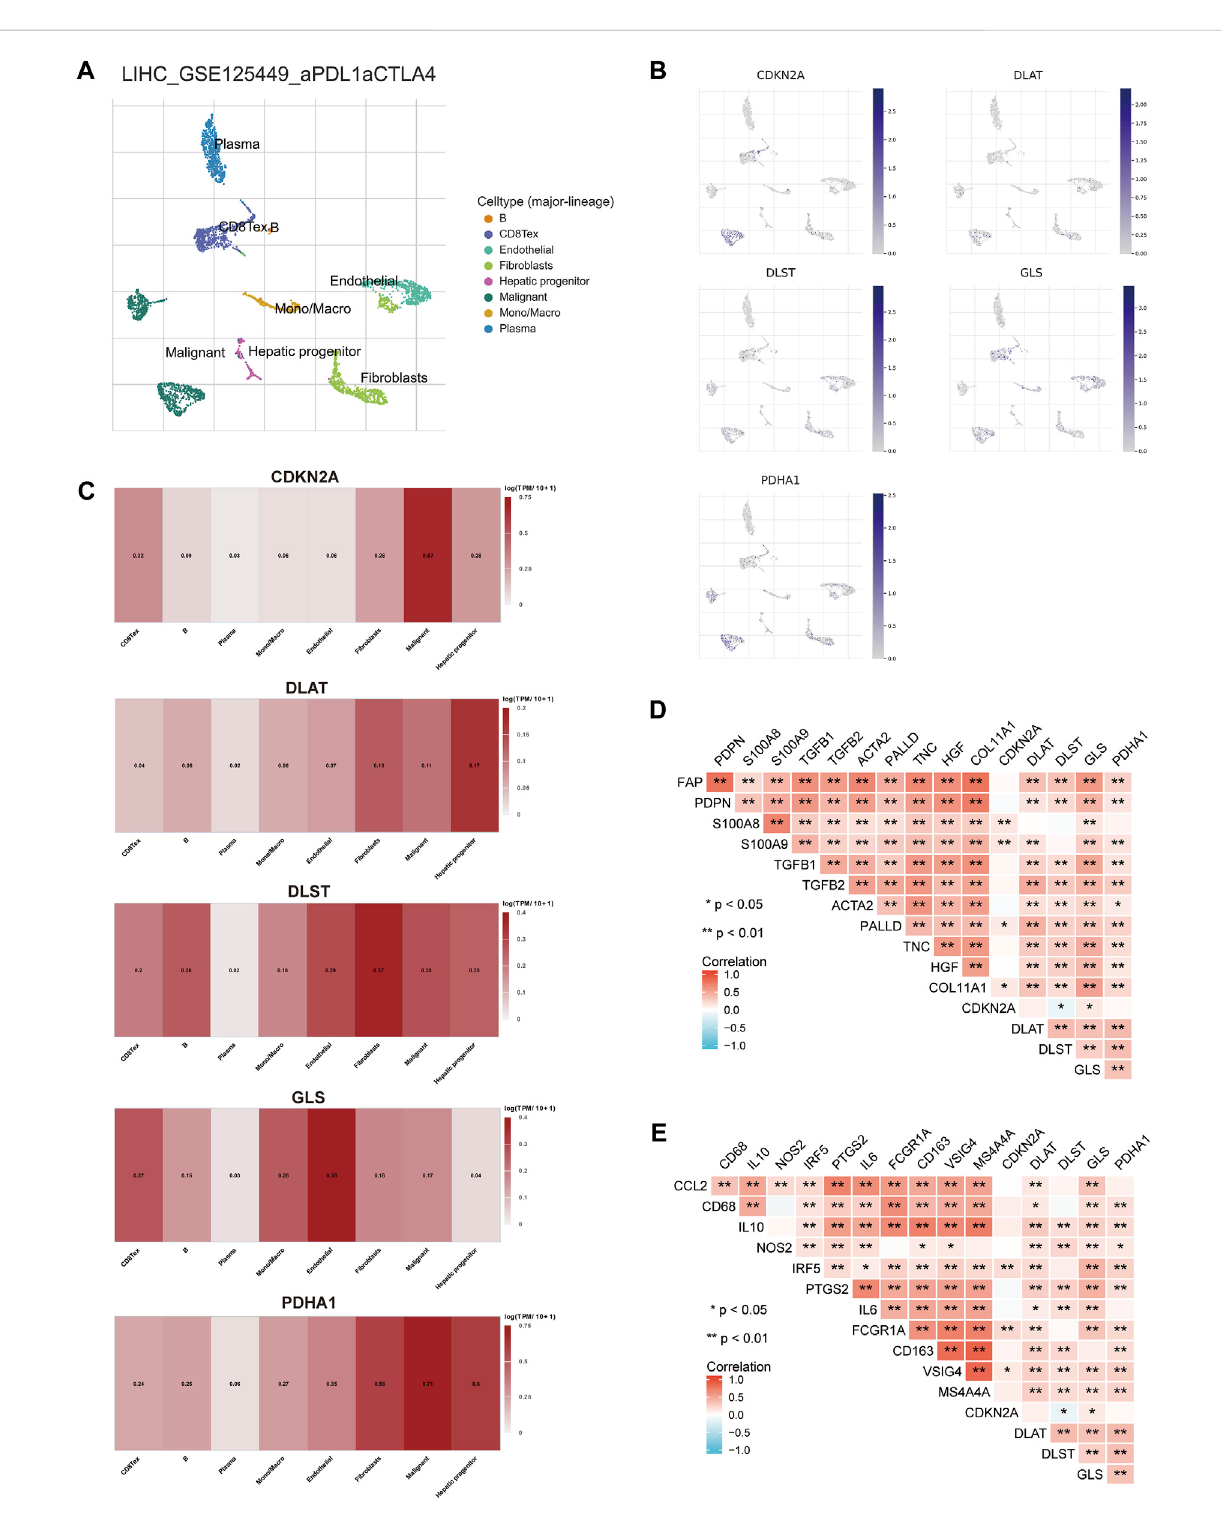
FIGURE 13 Expression ofCRGsindifferentimmunecelltypesinHCC. (A) Clusterdiagramofcelltypes inscRNA-seqdata.t-SNEplotshowingtheexpressionof differentimmunecells(LIHC_GSE125449_aPDL1aCTLA4)inlivercancertissue. (B,C) Characteristicmapsofprognostic CRGsobtained fromscRNA-seq data. (D) CorrelationbetweenprognosticCRGsandCAF-relatedmarkers. (E) CorrelationbetweenprognosticCRGsandTAM-relatedmarkers.** p < 0.01; CAF, cancer-associated fi broblasts; TAM, tumor-associated